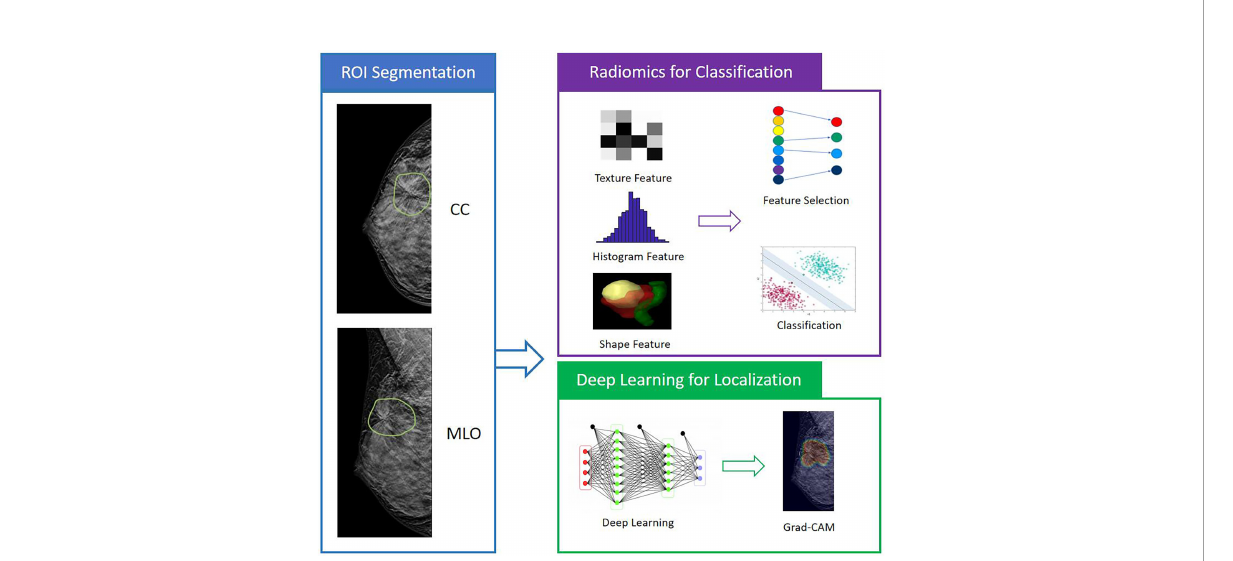
FIGURE 1 The analysis fl owchart. The ROI is manually outlined on the CC and MLO view of one DBT image that shows the most obvious architectural distortion. The radiomic features are extracted using PyRadiomics, and then SVM is applied to select important features and build the classi fi cation model to differentiate benign and malignant cases. For the deep learning analysis, the whole image is used as input into ResNet50 to train the diagnostic model. The Gradient-weighted Class Activation Mapping (Grad-CAM) reveals the suspicious area that is focused on to perform classi fi